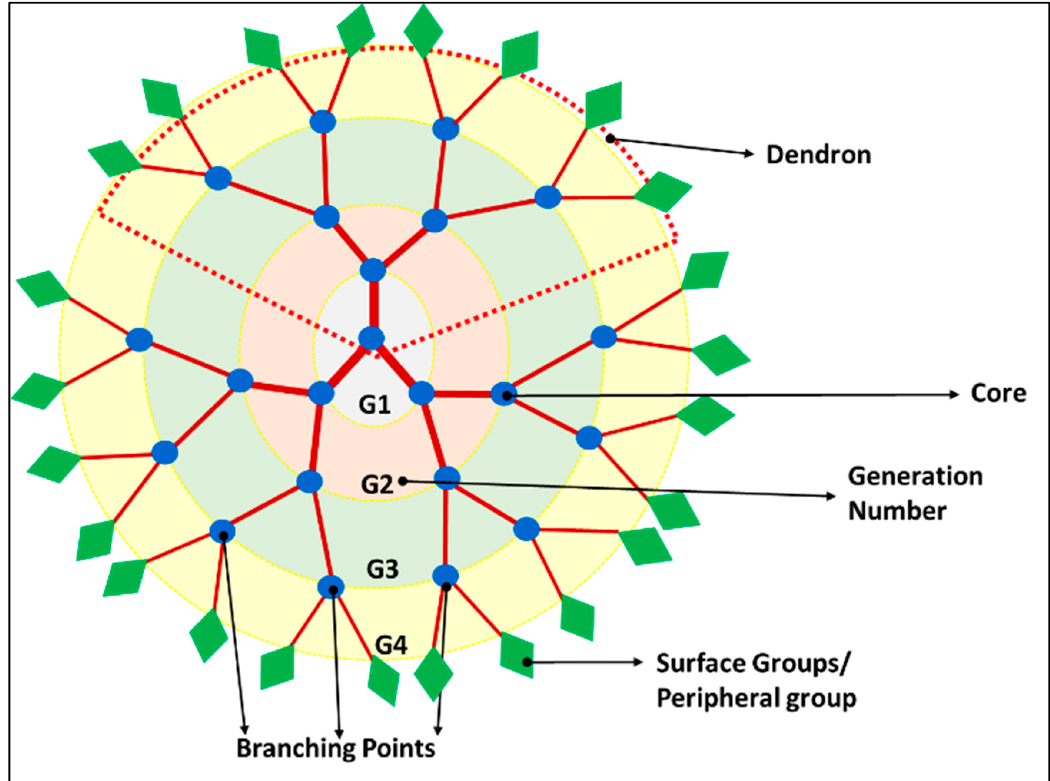
Figure 5. Dendrimers structural components include the core, branching points (blue circles), sur- face/peripheral groups (green rhombus), and the a dendron segment in a dotted red